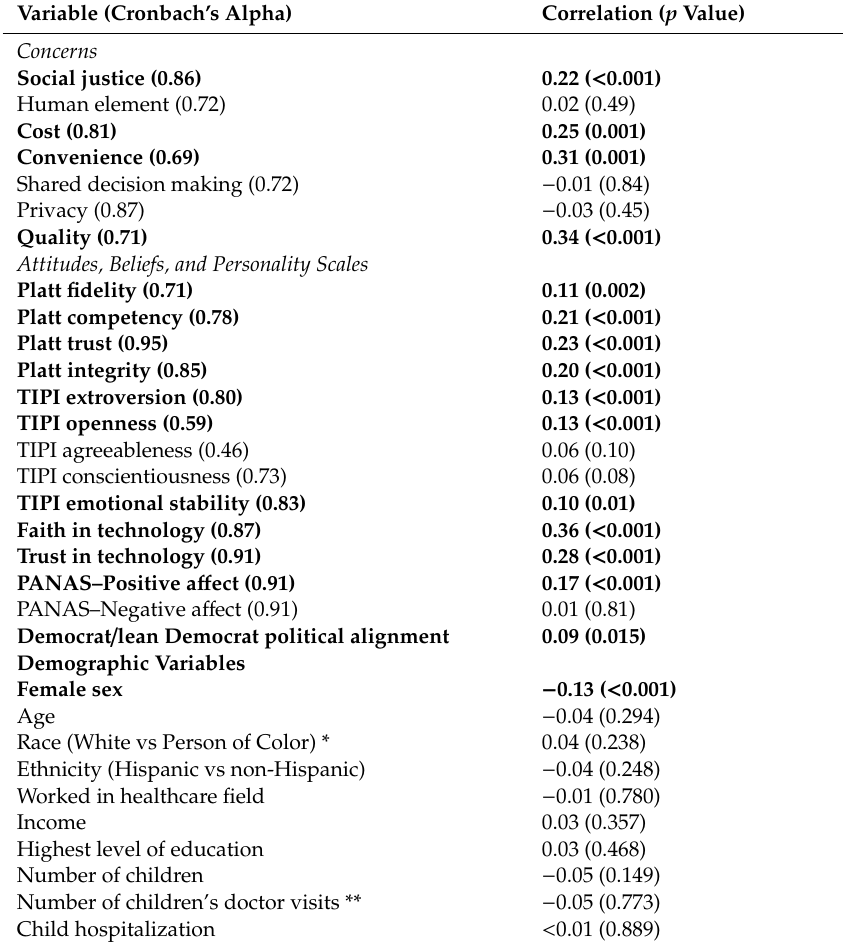
Table 3. Bivariable correlations with openness to AI-driven interventions in pediatrics